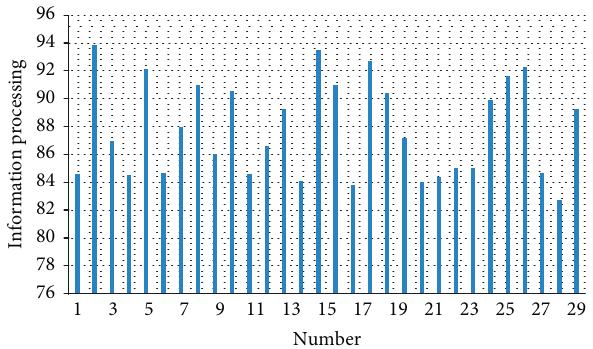
Figure 9: Statistical diagram of the prediction effect of the mul- timedia network information popularity prediction system based on the fast K neighbor